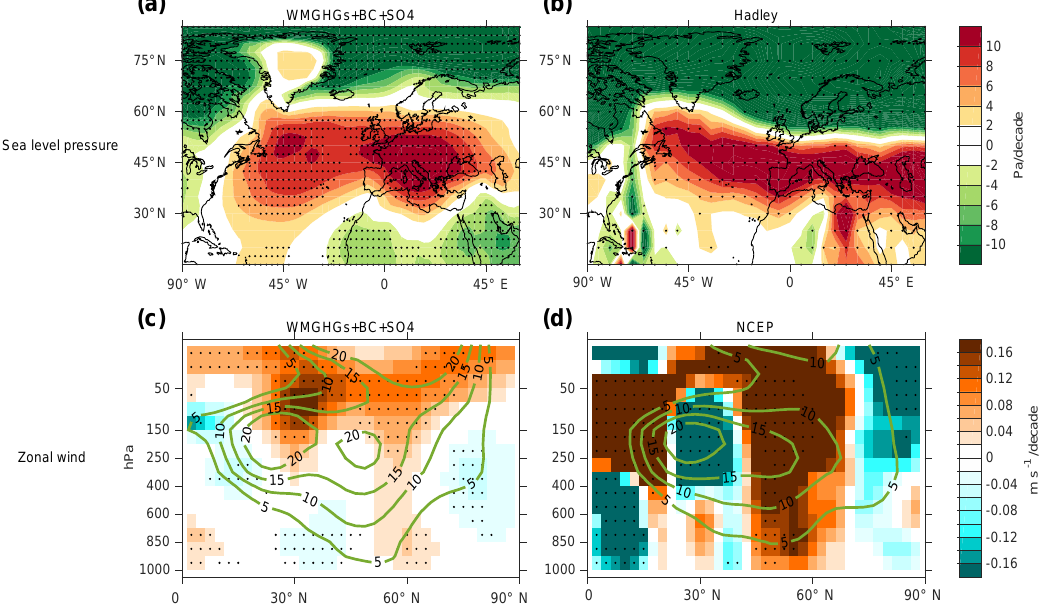
Figure 7. SLP (a, b) and zonal wind change (c, d) . Panels (a) and (c) are scaled change for the combination of WMGHGs, BC and SO 4 , while panels (b) and (d) are Hadley observational data and NCEP reanalysis data, respectively. Dots indicate the changes are significant at 0.95 confidence level. The green contours in panels (c) and (d) represent the climatology position of the zonal wind. The contours are at the interval of 5ms − 1 , with positive values indicating eastward